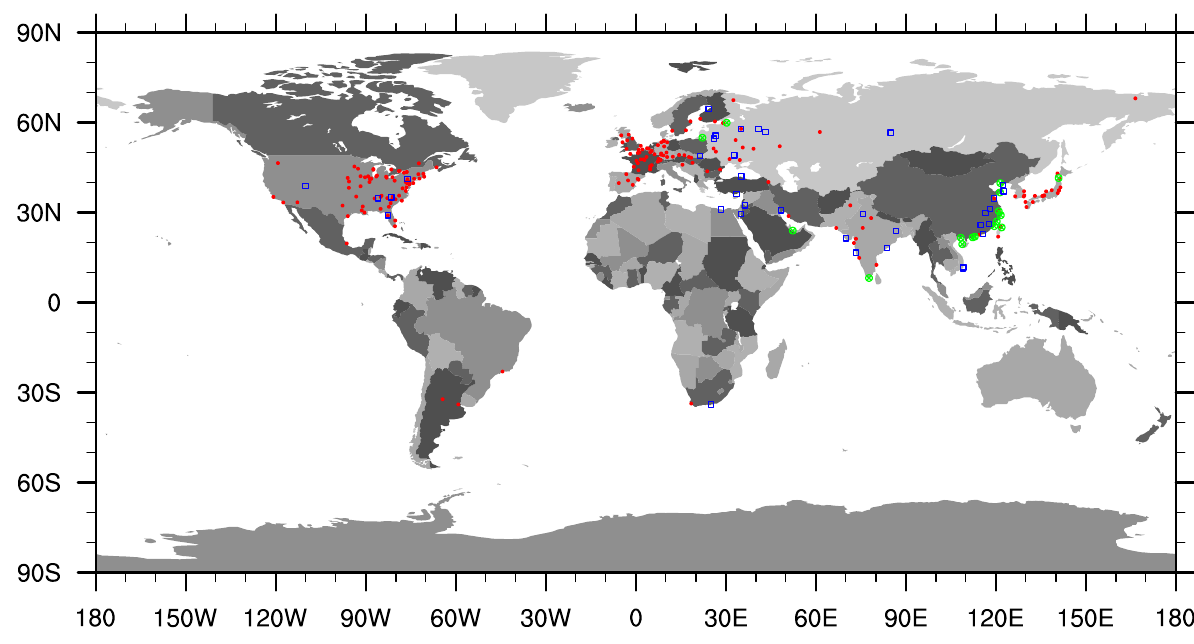
Figure 1. Geographical distribution of emission sites corresponding to nuclear power plants that are operational (red circles), under construction (green crossed circles) and planned or proposed (blue squares), adapted from [4]. Source: World Nuclear Association (WNA) Reactor